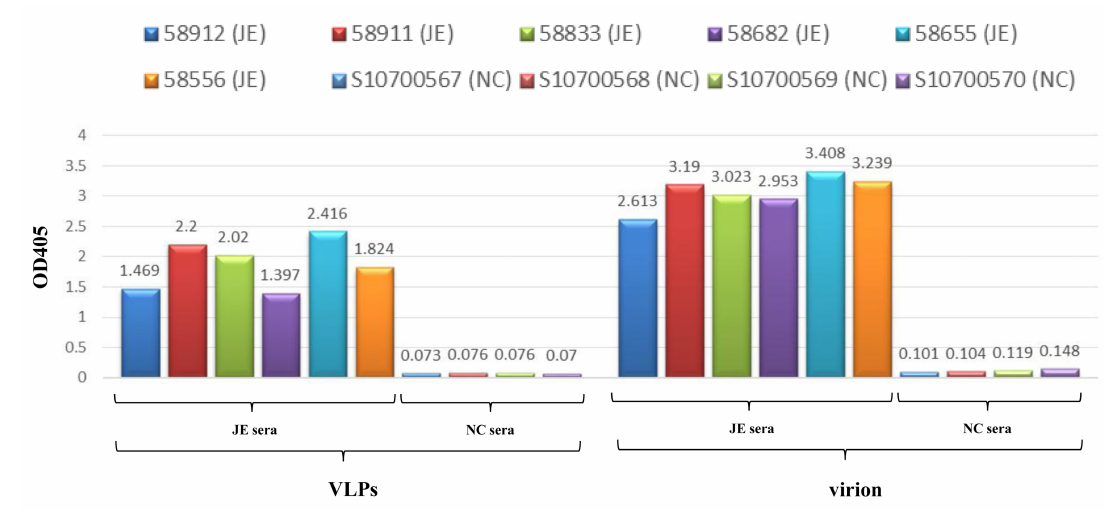
Figure 5. Epitope analysis of JEV VLPs. JEV VLPs ( left ) and virions ( right ) were subjected to MAC-ELISA for human sera, including six sera of JEV infection (JE sera): 58,912 (JE), 58,911 (JE), 58,833 (JE), 58,682 (JE), 58,655 (JE), and 58,556 (JE); as well as four normal sera (NC sera): S10700567 (NC), S10700568 (NC), S10700569 (NC), and S10700570